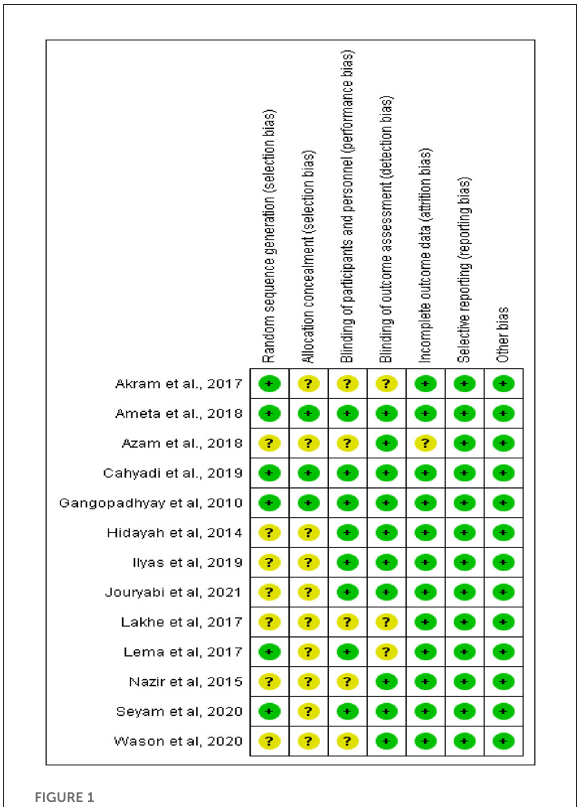
FIGURE1 The risk of bias assessment of included